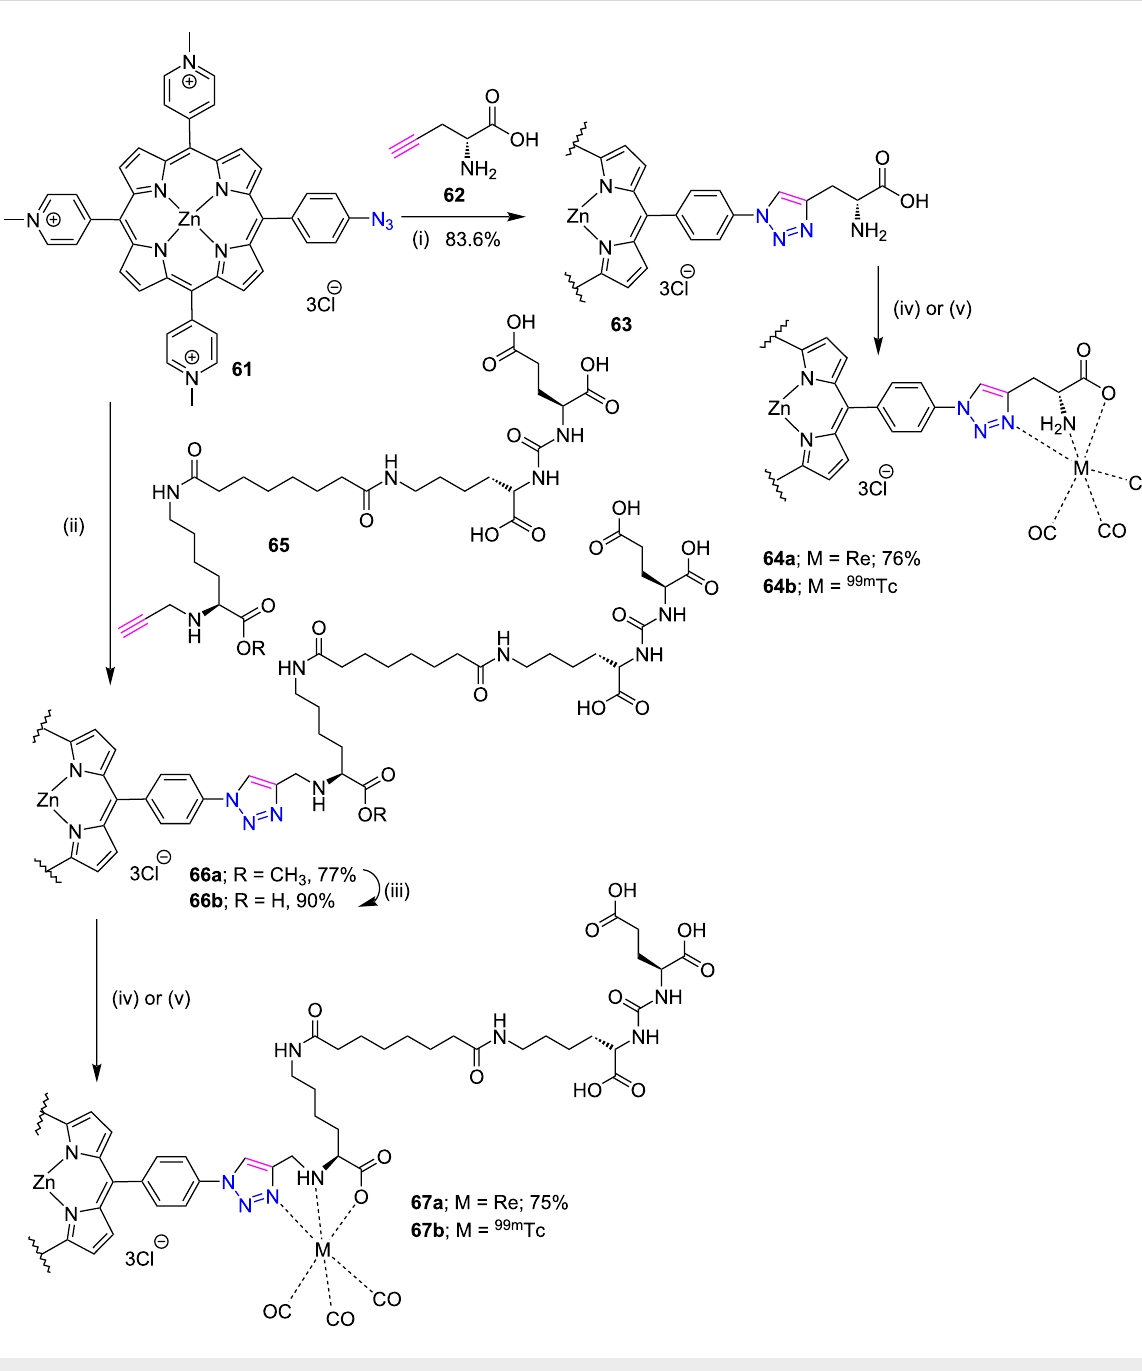
Scheme 12: Synthesis of porphyrin conjugates 64a , b and 67a , b . Reaction conditions: (i) CuSO 4 , sodium ascorbate, MW, 50 °C (ii) CuSO 4 , sodium ascorbate, tris[(1-benzyl-1 H -1,2,3-triazol-4-yl)methyl]amine, MW, 70 °C (iii) LiOH, water, room temperature, 3 h (iv) phosphate buffer pH